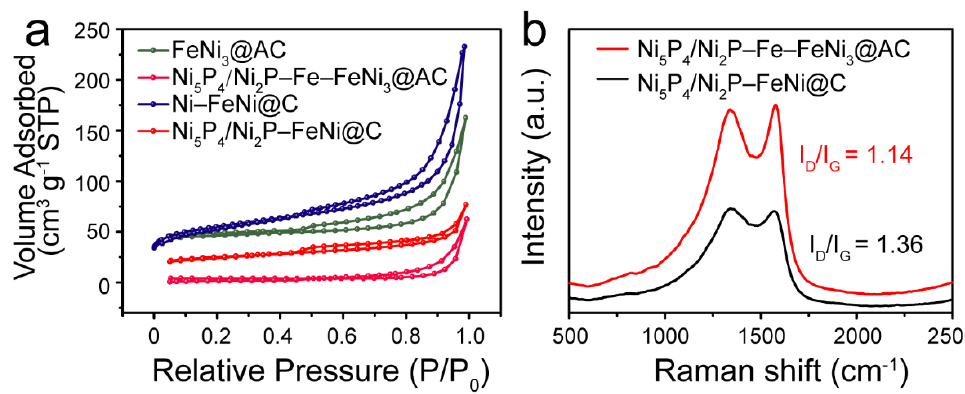
Figure 5. ( a ) N 2 adsorption–desorption isotherm of all samples; ( b ) Raman spectrum of Ni 5 P 4 /Ni 2